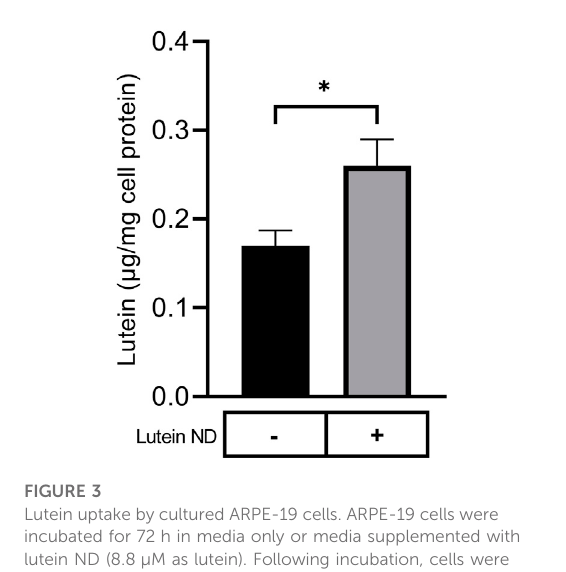
FIGURE 3 Lutein uptake by cultured ARPE-19 cells. ARPE-19 cells were incubated for 72 h in media only or media supplemented with lutein ND (8.8 µM as lutein). Following incubation, cells were washed to remove unincorporated lutein and suspended in methanol containing fucoxanthin as internal standard. The samples were homogenized, fi ltered and lutein content analyzed by reversed phase HPLC. Values reported are themean ± standard error ( n = 3); p = p < 0.05 vs. control.